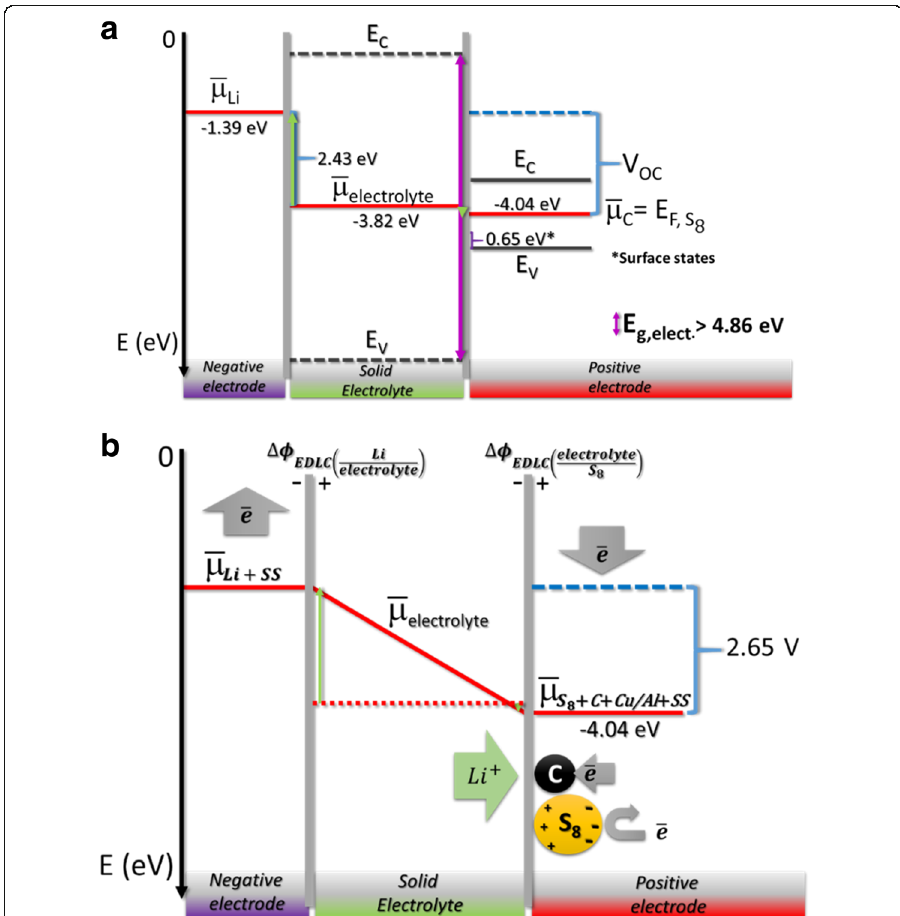
Fig. 2 Li-S all-solid state battery cell containing stainless steel (SS) current collectors in contact with both electrodes, lithium negative electrode and sulfur S 8 +carbon positive-electrode with copper or aluminum positive current collector; a before equalization of the electrochemical potentials of the electrodes with the electrolyte; b after equalization of the electrochemical potentials during discharge. The electrochemical potential of the positive electrode is smaller than the chemical potential of the unmixed electrolyte reference. The energy loss by the Joule effect due to the resistances inside the cell was not